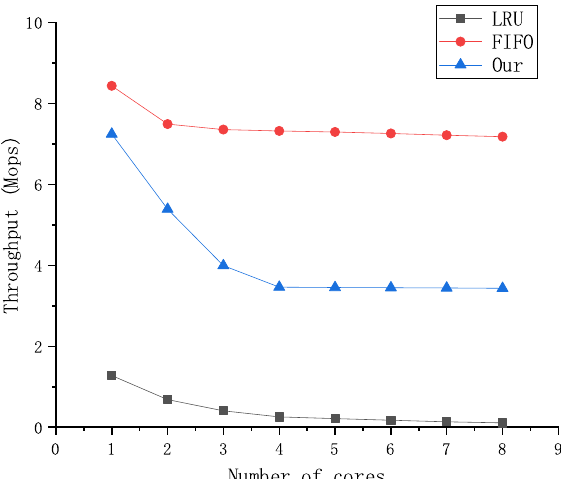
Figure 12. The average throughput of each core with different number of